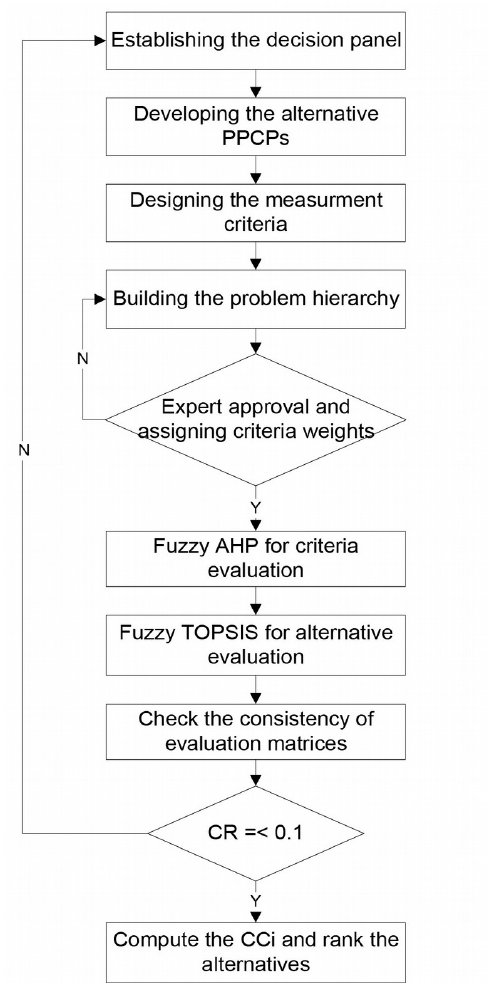
Figure 2. Proposed fuzzy multi-criteria decision-making